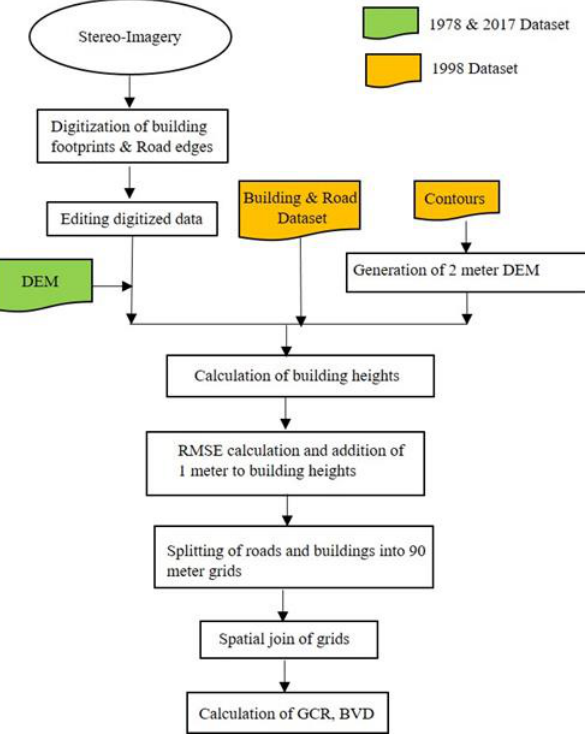
Figure 3: Flowchart of building height, GCR & BVD